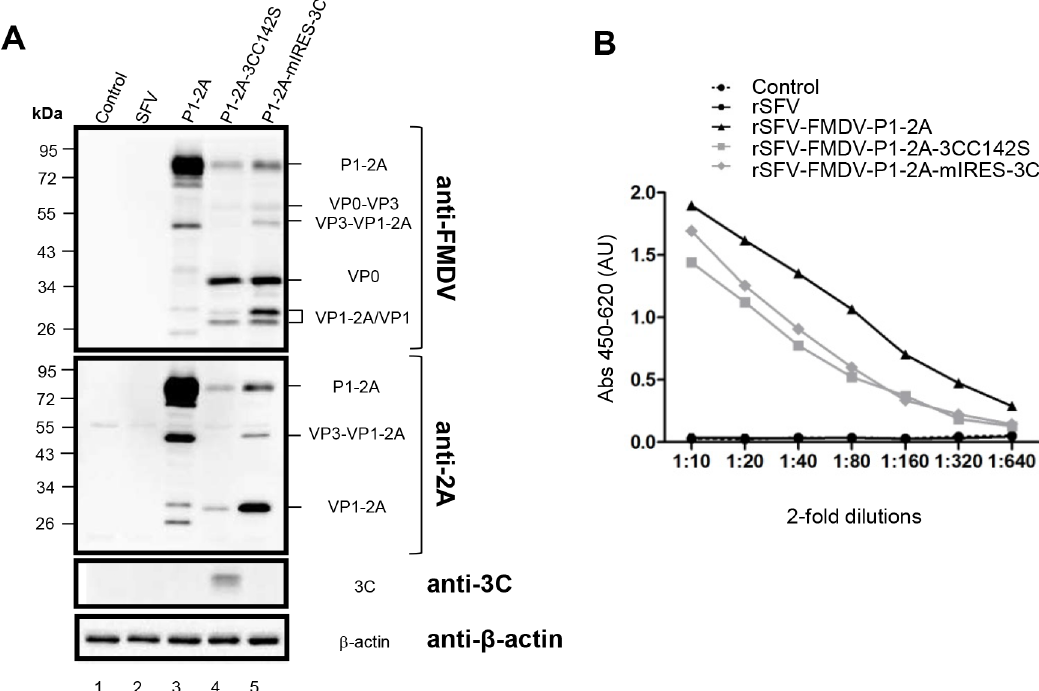
Fig 3. Characterization of expressed FMDV capsid proteins. (A) Uninfected BHK cells (control, lane 1) or cells infected with rSFV (lane 2), rSFV-FMDV-P1-2A (lane 3), rSFV-FMDV-P1-2A-3CC142S (lane 4) or rSFV-FMDV-P1-2A- mIRES-3C (lane 5) were harvested and the cell lysates were fractionated by SDS – PAGE. The proteins were transferred to PVDF membrane and probed with antibodies specific for FMDV capsid proteins (top), FMDV 2A (second), FMDV 3C pro (third) and β -actin (bottom) as indicated. Detection of β -actin was used as a control for equal protein loading. The results shown are representative of three independent experiments. Molecular mass markers (kDa) are indicated on the left. (B) Cell lysates, as used in panel A, were diluted (10-fold initially and then 2-fold dilutions) and analysed with a FMDV serotype O-specific antigen ELISAs. The results shown are representative of two independent experiments. AU, absorbance